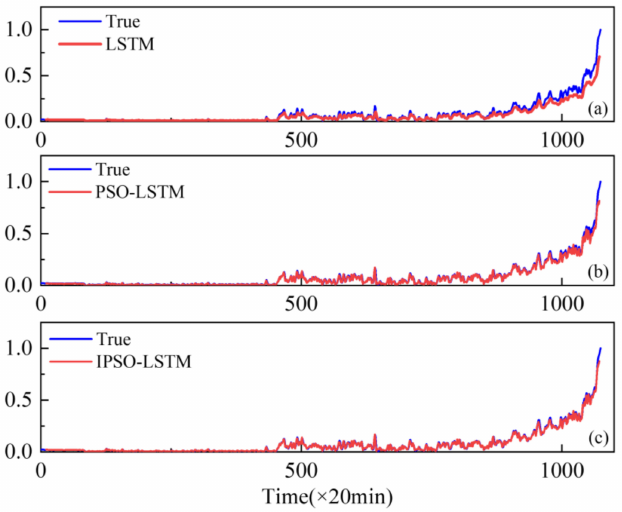
Figure 8. Performance degradation predictions of inner bearings for the: ( a ) LSTM; ( b ) PSO-LSTM; ( c ) IPSO-LSTM. Table 3. The RMSE of LSTM with different optimization methods. RMSE Outer Roller Inner LSTM